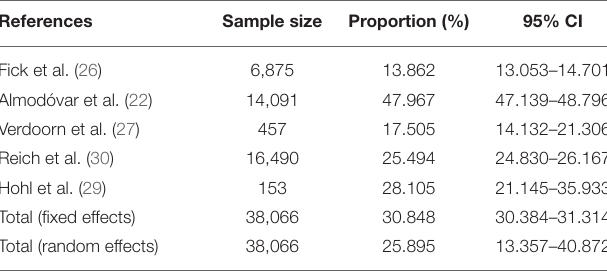
TABLE 4 | Results of proportion distribution and likelihood of a